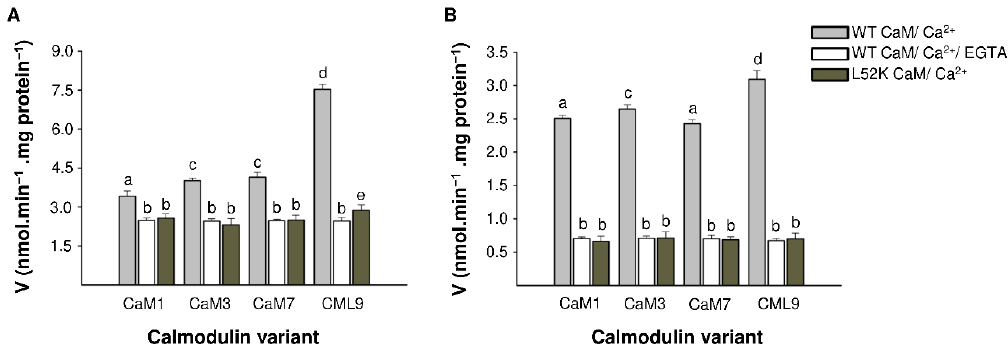
Figure 4. Regulation of the enzyme activity by CaM and CaM-like isoforms. ( A ) BDPDE1 and BDPDE1 L52K activity in the presence of various CaM isoforms, which were in active or inactive complexes (addition of 1-mM EGTA chelate). The reaction was carried out for 25 min in the standard reaction mixture containing 0.1-mM cAMP, 0.625- µ M GST-BDPDE1, 2- µ M of each CaM isoform, 12.5- µ M CaCl 2 and 1-mM EGTA, depending on the variant. Different letters indicate significantly different data between the groups at p < 0.05. ( B ) The BDPDE1 and BDPDE1 L52K activity in the presence of various CaM isoforms, where 0.1-mM cGMP was used as a substrate.